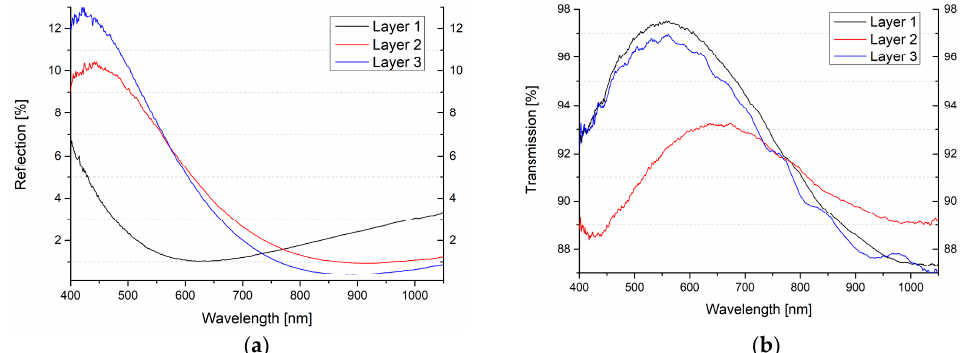
Figure 12. ( a ) Reflectance curve of layers 1–3; ( b ) Transmission curves of layers 1–3; Layer 1: MgAlF 5 ; Layer2: MgAl 2 F 8 ; Layer3: Mg 2 AlF 7 . Reproduced from Reference [48] with the permission of the Royal Chemical Society.